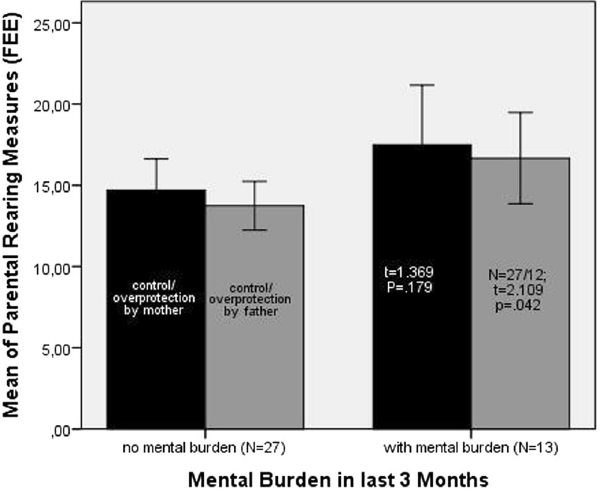
Figure 1. Parental child rearing styles of the FEE in subjects with and without mentally burdening events in the previous 3 months. Two-tailed test; error-bars 95%CI; One questionnaire of the paternal Recalled Parental Rearing Behavior Questionnaire (FEE) was missing. Paternal rearing measures of overprotecting (mean = 16.7 ± 4.4 SD, N = 12) compared to subjects without mentally burdening events (mean = 13.7 ± 3.8 SD, N = 27) in the previous three months. Maternal overprotecting in mentally burdened subjects (mean = 17.1 ± 5.7 SD, N = 13) compared to subjects without mentally burdening event (mean = 14.7 ± 4.8 SD, N = 27) in the previous three months.